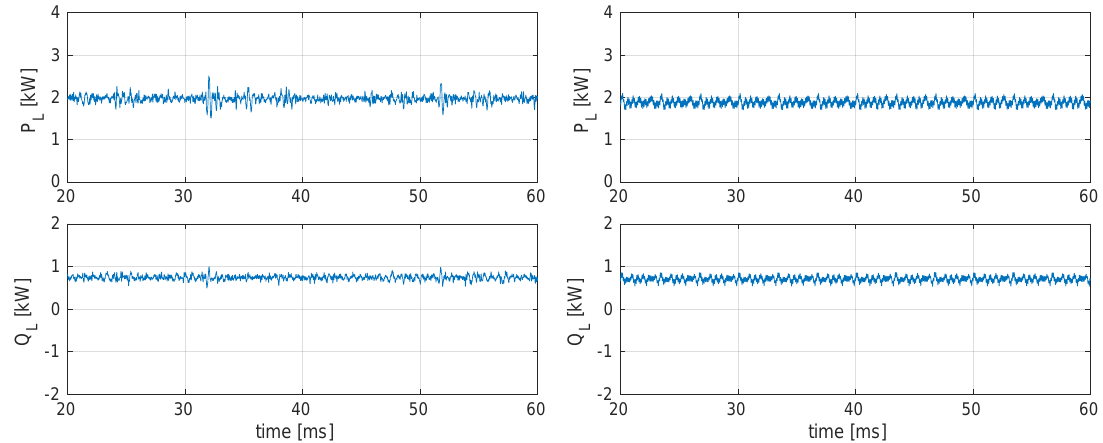
Figure 12. Simulation results of the active and reactive power at the load ( P L , Q L ). ( Left ): sigma-delta modulator. ( Right ): SVM.